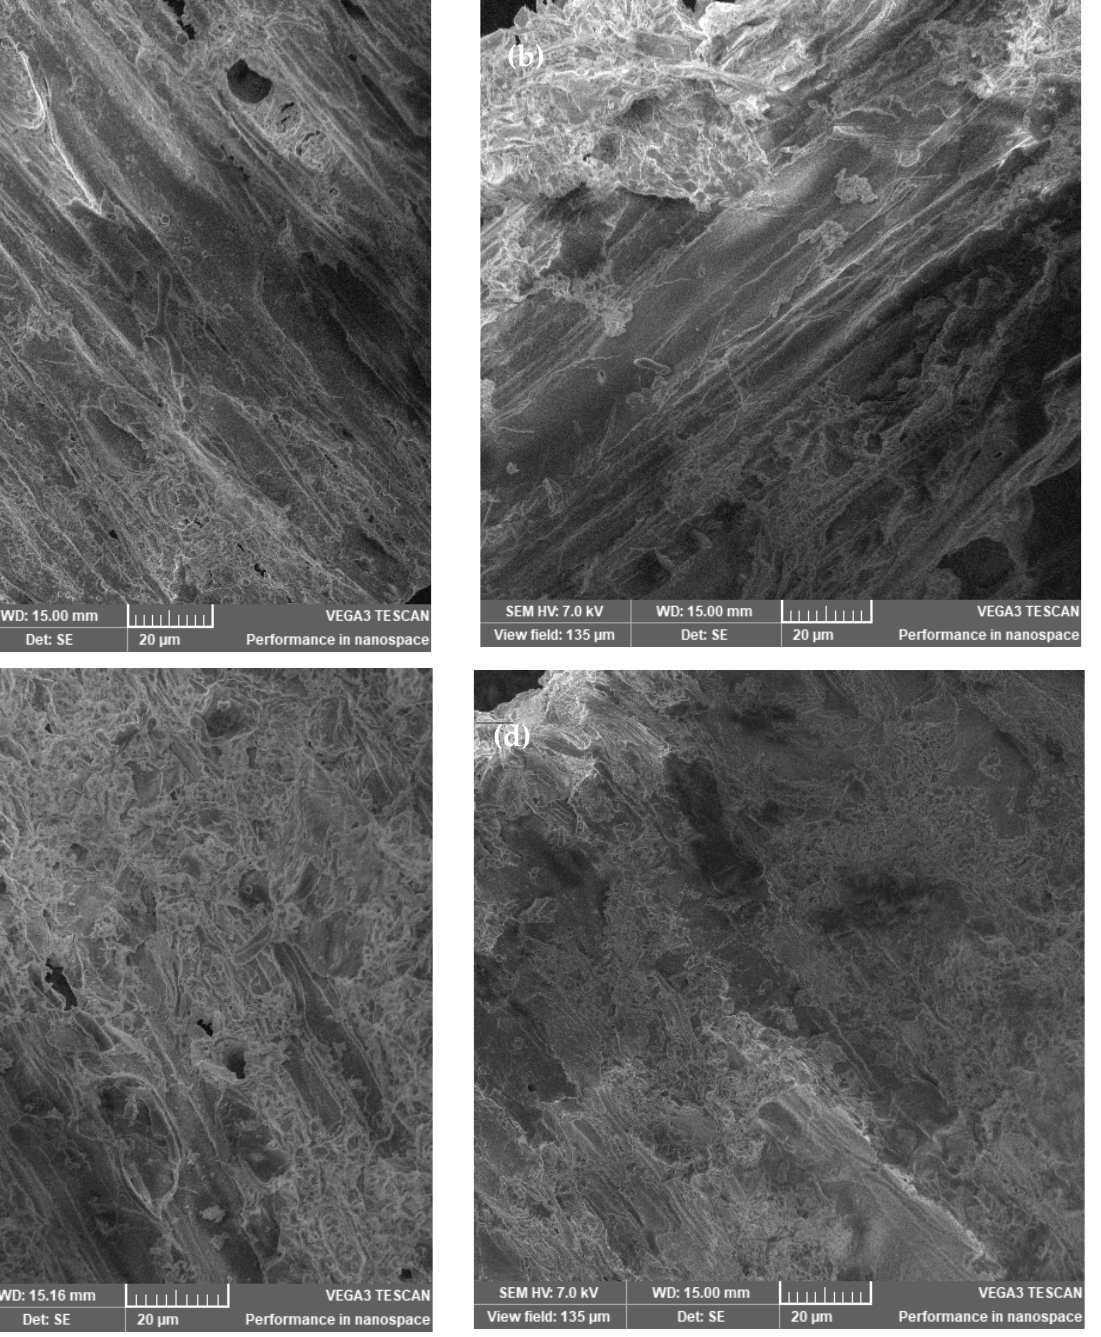
Figure 8. SEM images of ( a ) raw material, ( b ) raw material pretreated at 160 ◦ C for 30 min, ( c ) raw material pretreated at 180 ◦ C for 30 min, and ( d ) raw material pretreated at 200 ◦ C for 30